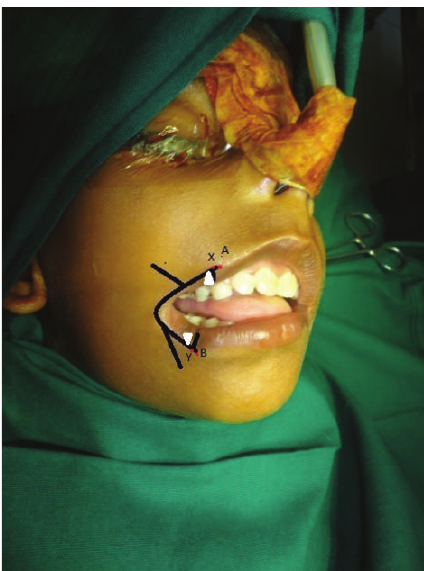
Figure 2: Intraoperative photographs with proposed incision mark- ings showing Z plasty limbs and mucosal flaps (white